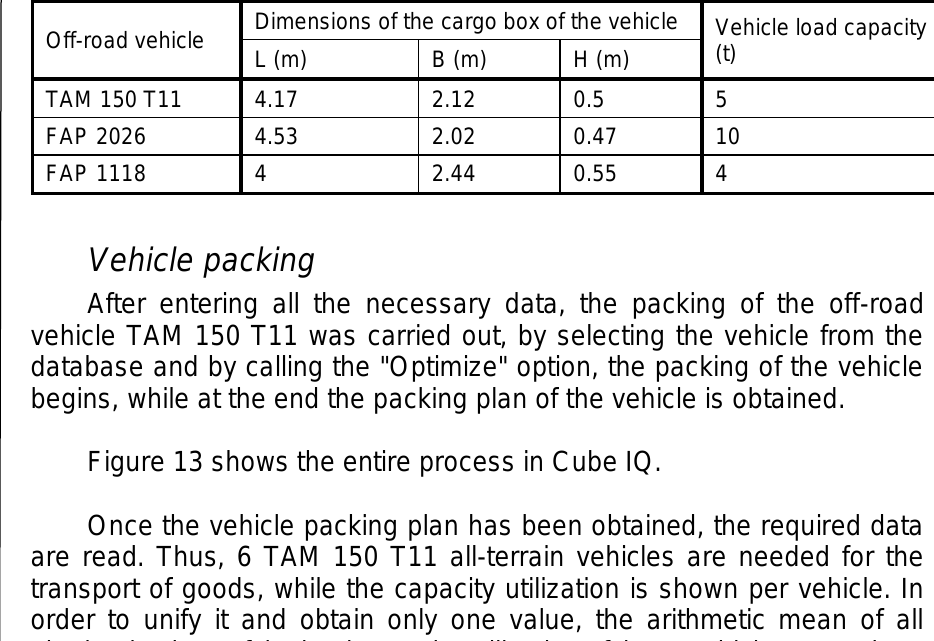
Dimensions of the cargo box of the